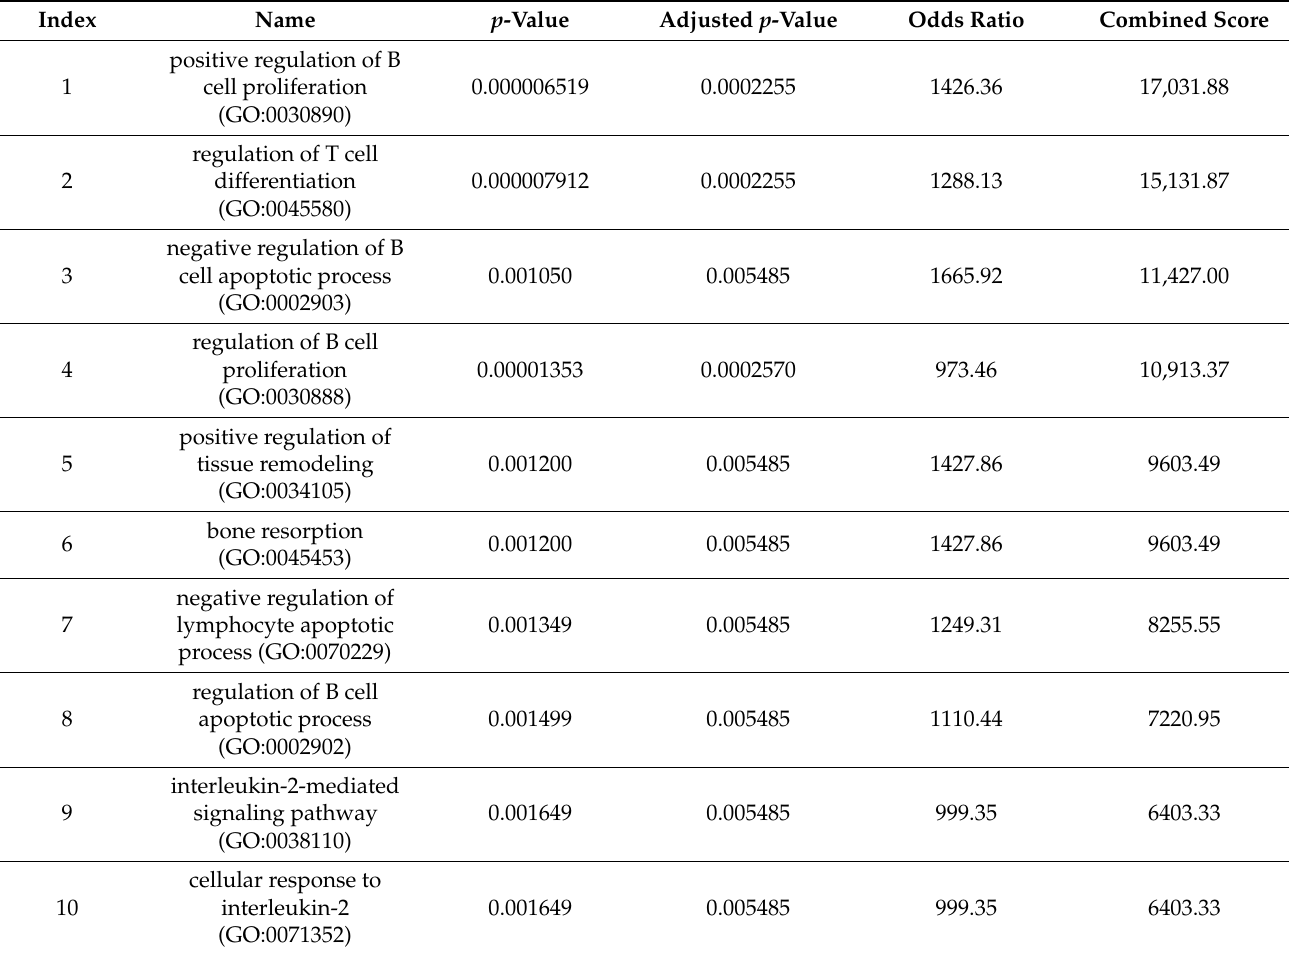
Figure 4. STRING bioinformatic analysis of proteins identified to be over-expressed in age-matched elderly individuals. The non-casual protein – protein interaction network was studied and predicted using STRING. The links between the proteins represent possible interactions (line thickness indi- cates the strength of association). The green lines indicate putative text mining associations sug- gested by further peer-reviewed publications; the black lines indicate putative co-expression; the pink lines indicate experimentally determined interactions; the blue lines indicate interactions sug- gested by curated databases; and the violet lines indicate protein homology.